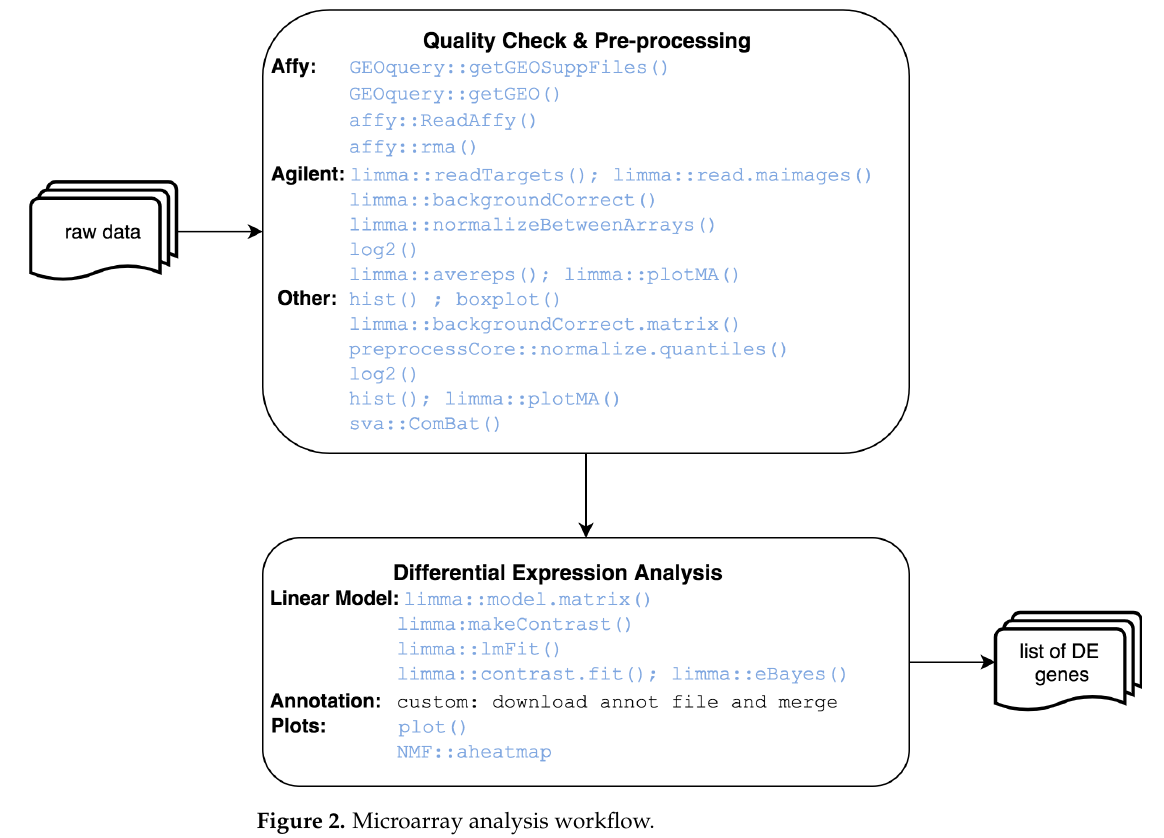
Figure 2. Microarray analysis workflow.